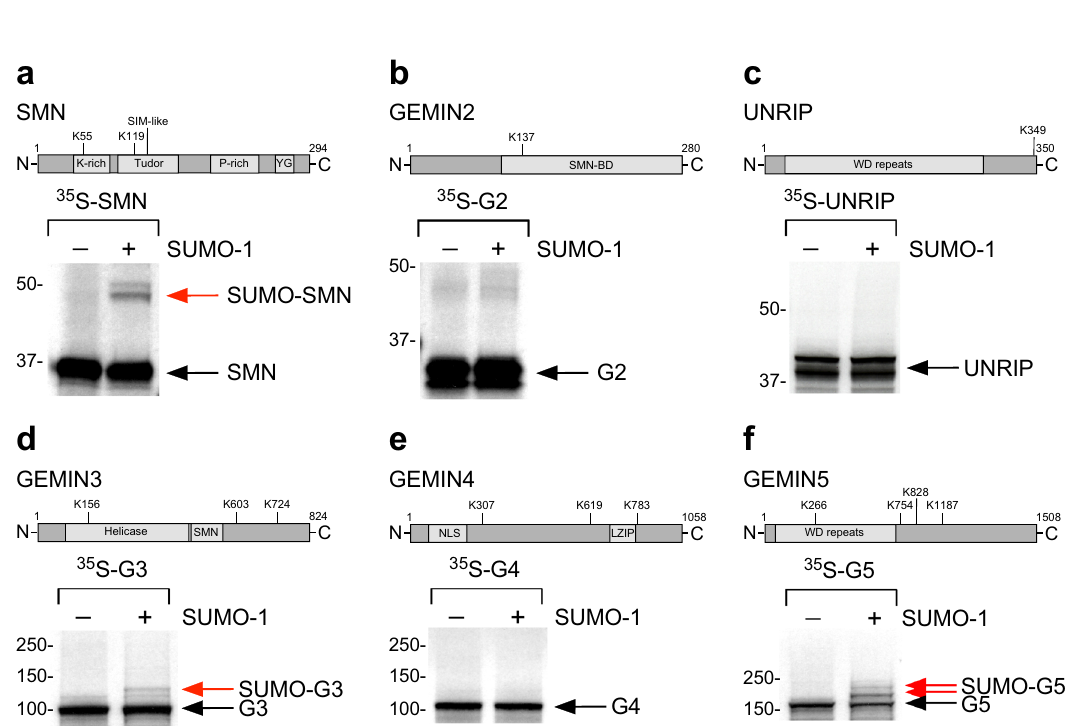
Fig. 1 Sumoylation is required for the localization and integrity of the SMN complex. a SDS-PAGE and Western blot analysis of endogenous UBC9 protein levels in HeLa wildtype (WT) or UBC9 RNAi cells cultured without (-) or with ( + ) Doxycycline (Dox) for 4 days. A twofold serial dilution of WT HeLa cell extract is analyzed on the left. b Western blot analysis of anti-SUMO-2/3 immunoprecipitates in HeLa WT or UBC9 RNAi cells cultured without ( − ) or with ( + ) Dox for 4 days. c Representative fl uorescent images of HeLa UBC9 RNAi cells cultured without ( − ) or with ( + ) Dox for 4 days and stained with antibodies against SMN, GEMIN2, GEMIN3, GEMIN5, and GEMIN6 (green), and with DAPI (blue). Cytoplasmic foci are indicated with white arrowheads. Scale bar, 10 μ m ( fi gures are representative of n = 3 biologically independent experiments). d Quanti fi cation of number of cells with cytoplasmic foci from the same groups as in ( c ). Data represent means and SEM ( n = 3 biologically independent experiments). Statistical signi fi cance was determined by two- sided, unpaired multiple t tests followed by Holm-Sidak correction (adjusted P values − Dox vs. + Dox: SMN = 0.023007; GEMIN2 = 0.026589; GEMIN3 = 0.010270; GEMIN5 = 0.023007; GEMIN6 = 0.023007). e Cell extracts from HeLa UBC9 RNAi cells cultured without ( − ) or with ( + ) Dox for 4 days were fractionated by 10 – 30% sucrose gradient centrifugation. Endogenous SMN levels in each fraction were analyzed by SDS-PAGE and Western blot. Numbers of fractions and sedimentation (S) values are indicated.